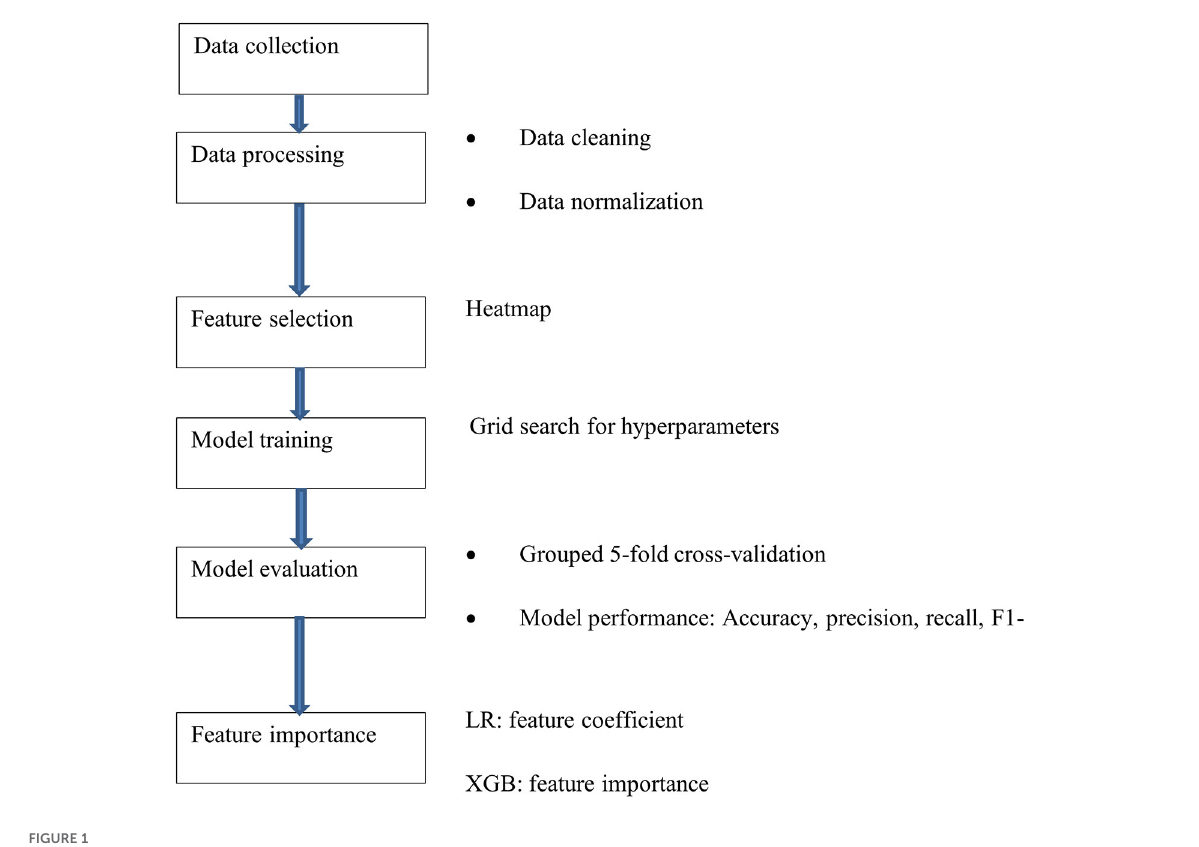
FIGURE1 Machine learning process.